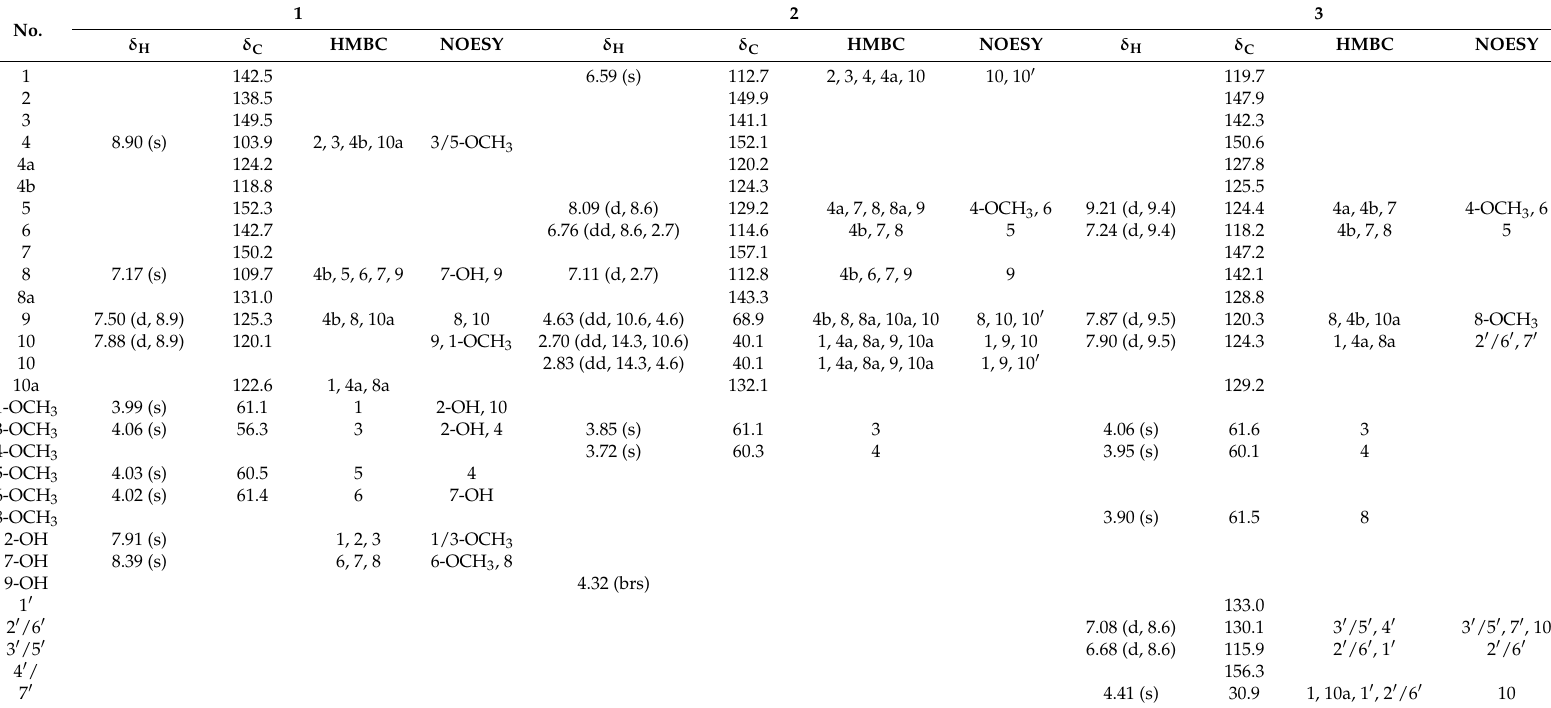
Table 1. 1 H (500 MHz) and 13 C (125 MHz), HMBC and NOESY spectroscopic data of compounds 1 – 3 ( δ in ppm, J in Hz) in acetone- d 6